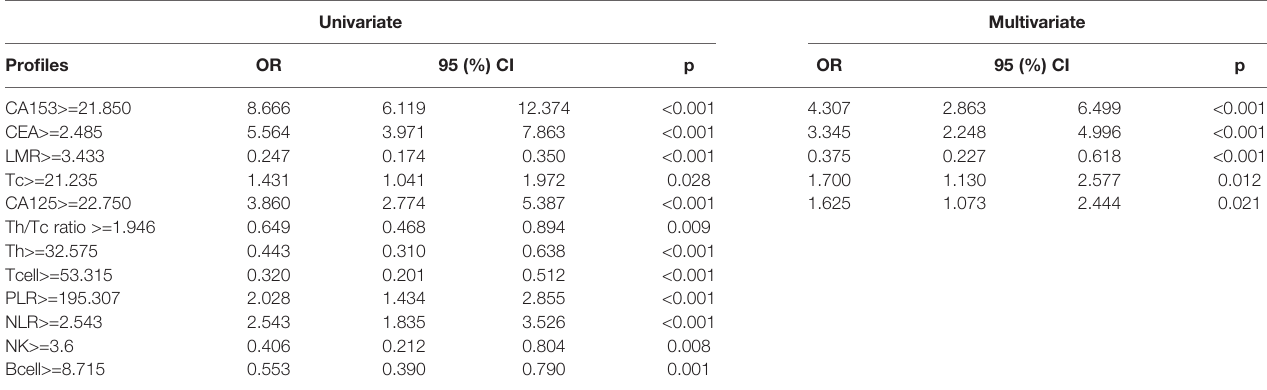
TABLE 2 | Univariate and multivariate logistic regression analysis predicts distant metastasis of BC. Univariate Multivariate Pro fi les OR 95 (%) CI p OR 95 (%) CI p